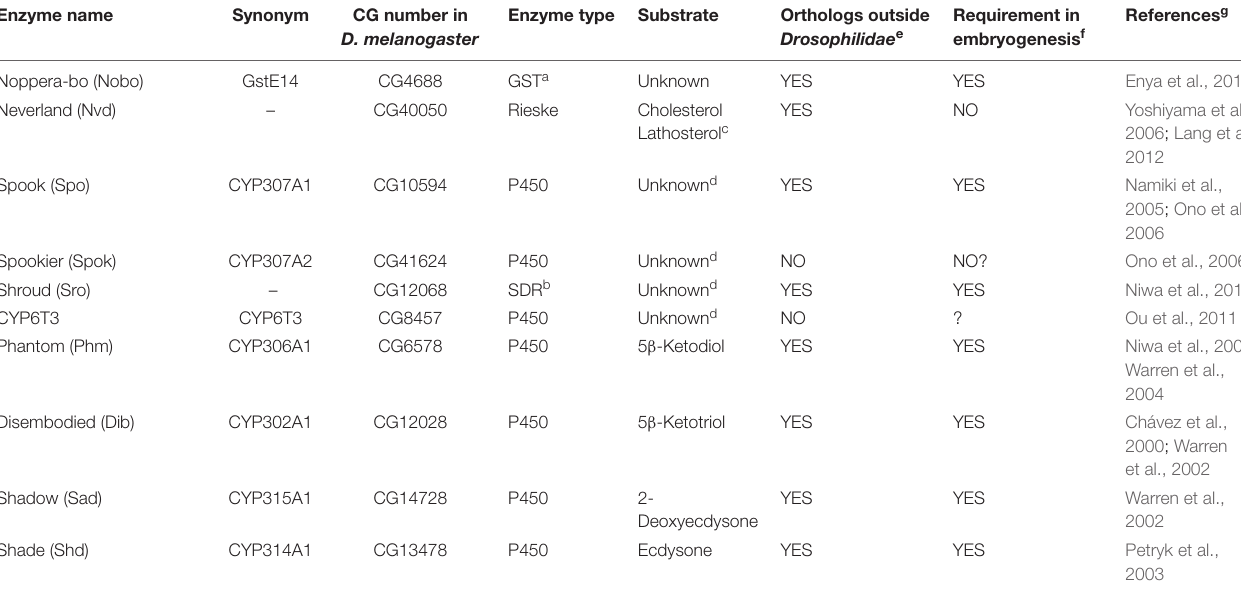
TABLE 1 | A list of ecdysteroid synthetic enzymes encoded by Halloween